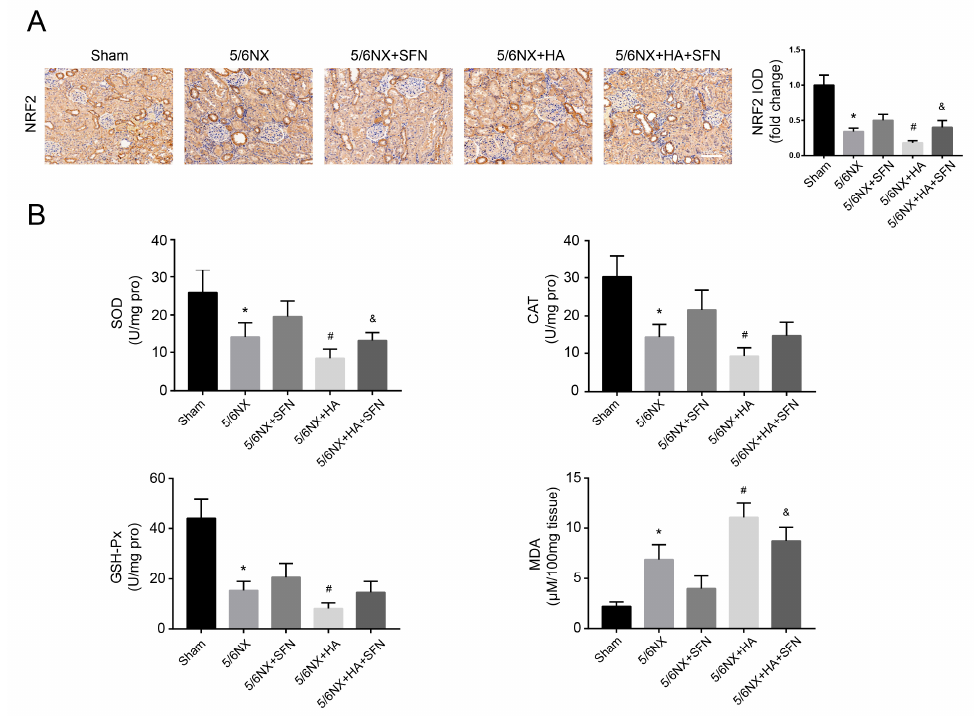
Figure 8. Effects of HA on redox imbalance in rat kidneys. ( A ) Immunohistochemistry for NRF2. Positive areas were quantified (right) by densitometry. Bar = 100 µm. ( B ) Levels of superoxide dismutase (SOD), catalase (CAT), glutathione peroxidase (GSH-Px), and malondialdehyde (MDA). Data are presented as the mean ± standard deviation ( n = 9 per group). * p < 0.05 vs. sham group; # p < 0.05 vs. 5/6th nephrectomy (5/6NX) group; and & p < 0.05 vs. 5/6NX + HA group.